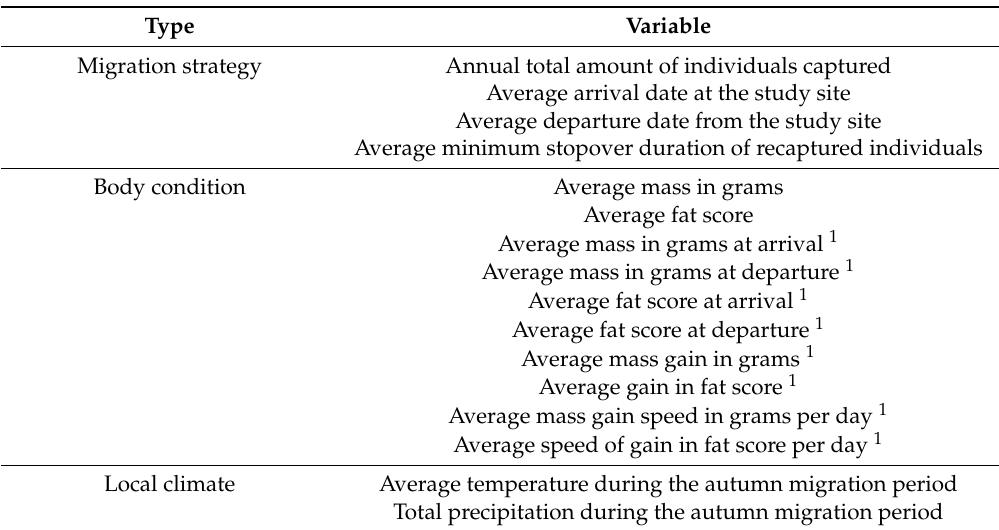
Table 1. All variables used in the analyses. Pied Flycatcher-related data were obtained from the A Rocha Portugal bird ringing database, and local climate variables were obtained from the weather station at the grounds of A Rocha